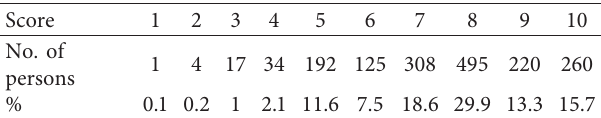
Table 6: IGSE administrators’ view on improvement of manage- ment quality through use of modern gadgets and messenger applications.